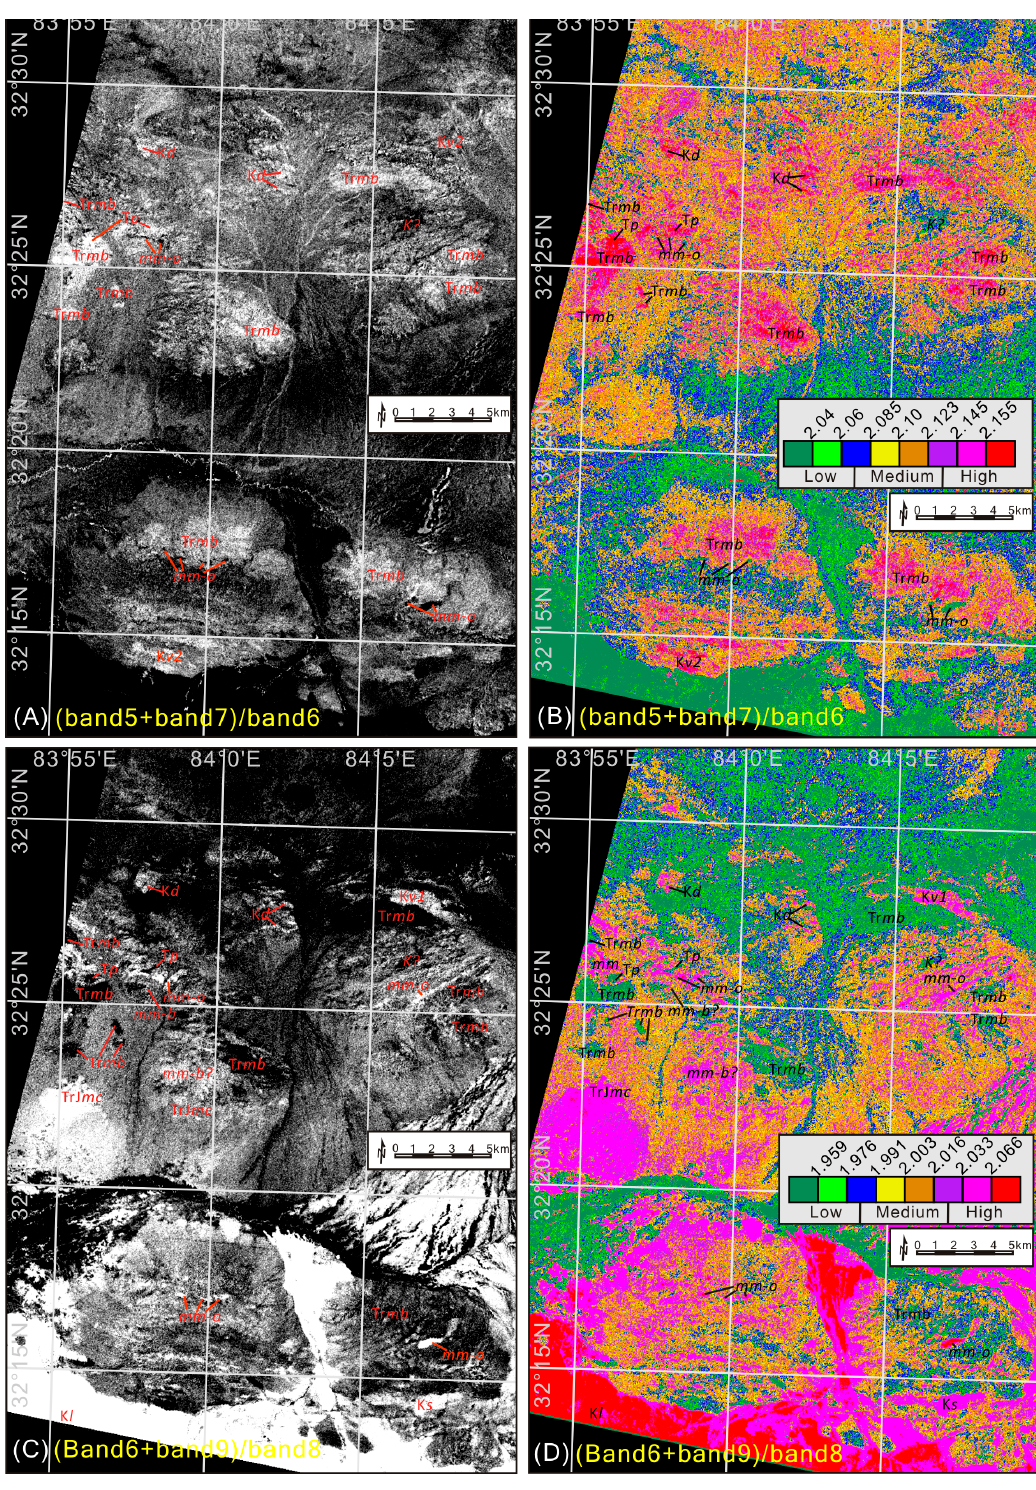
Figure 11. Grayscale and classified color images of SWIR indexes. ( A , B ) Band ratio (band 5 + band 7)/band 6 ; ( C , D ) Band ratio (band 6 + band 9)/band 8 . See text and Figure 8 for interpretation of the labels of lithologic units.